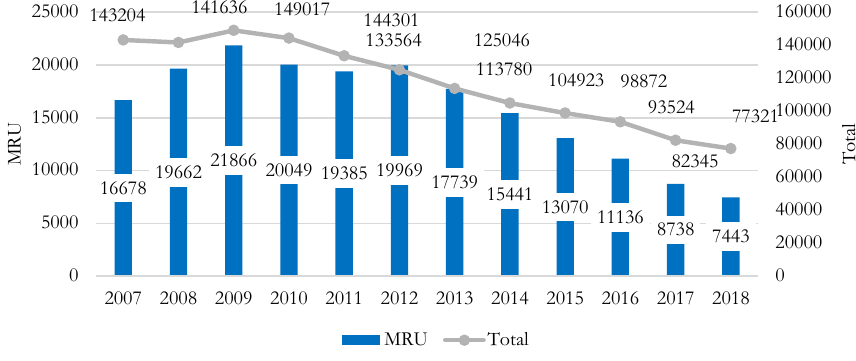
Fig. 2 – Dynamics of students’ number in Lithuania. Source: Statistics Lithuania (2019); Mykolas Romeris University